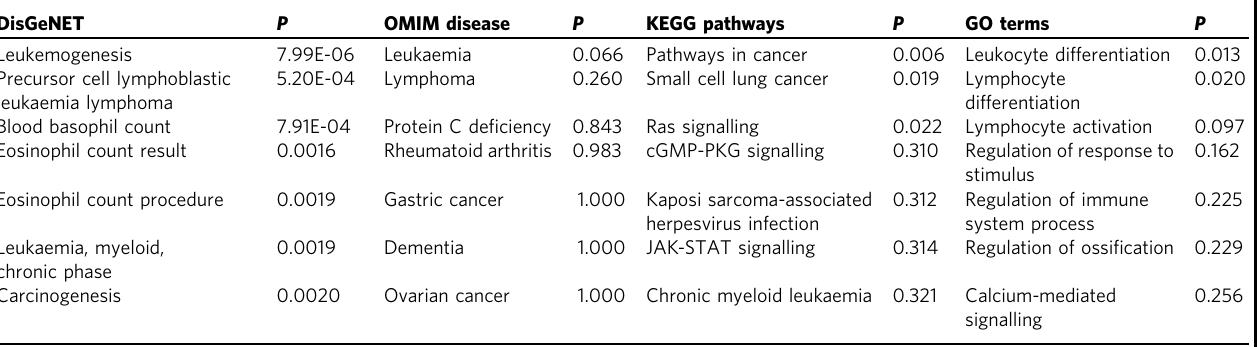
Table 1 Gene enrichments for sets of genes closest to tumour-speci fi c IS. DisGeNET P OMIM disease